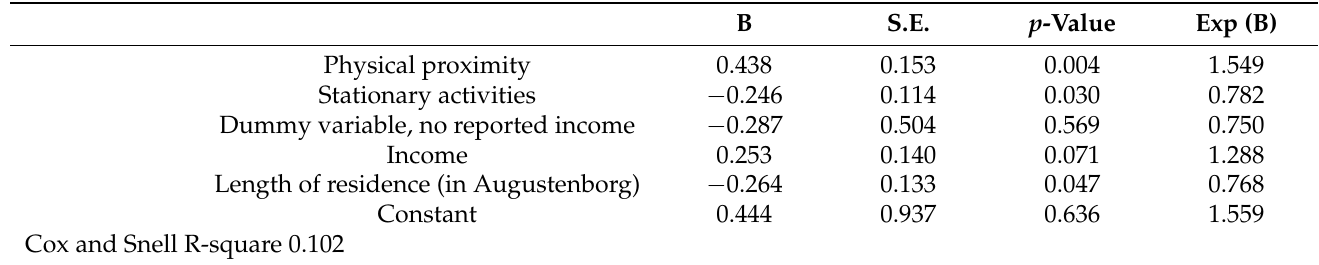
Table 3. Result of the univariate probit model in which the dependent variable is the neighborhood preference from the photomontage question about living with or without